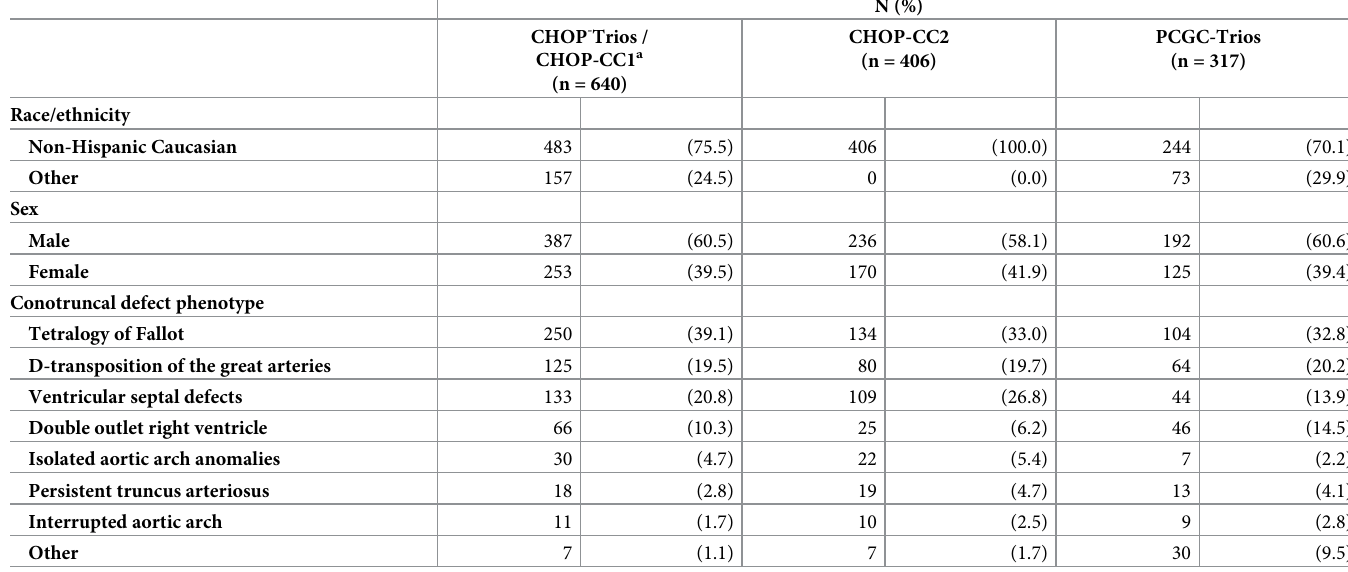
Table 1. Characteristics of patients with conotruncal defects in the Children’s Hospital of Philadelpia (CHOP) and Pediatric Cardiac Genomics Consortium (PCGC)